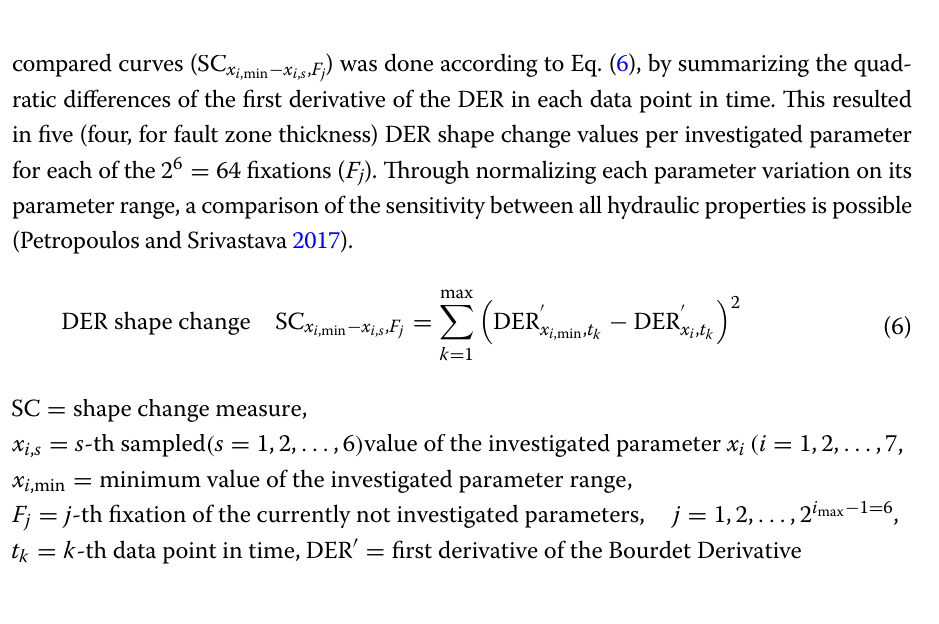
Table 3 Median values of SC x Variable value normalized on parameter range